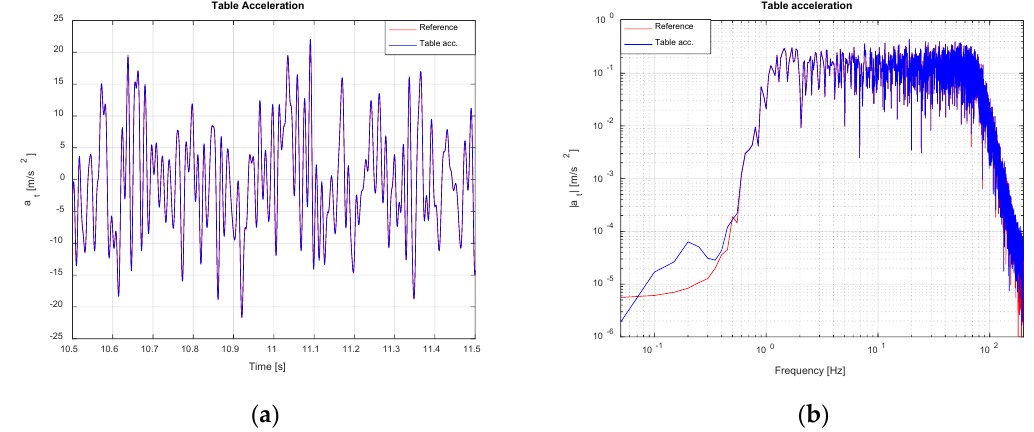
Figure 20. Shake table acceleration tracking (noise-free scenario). TVC Enabled: ( a ) Time domain; ( b )